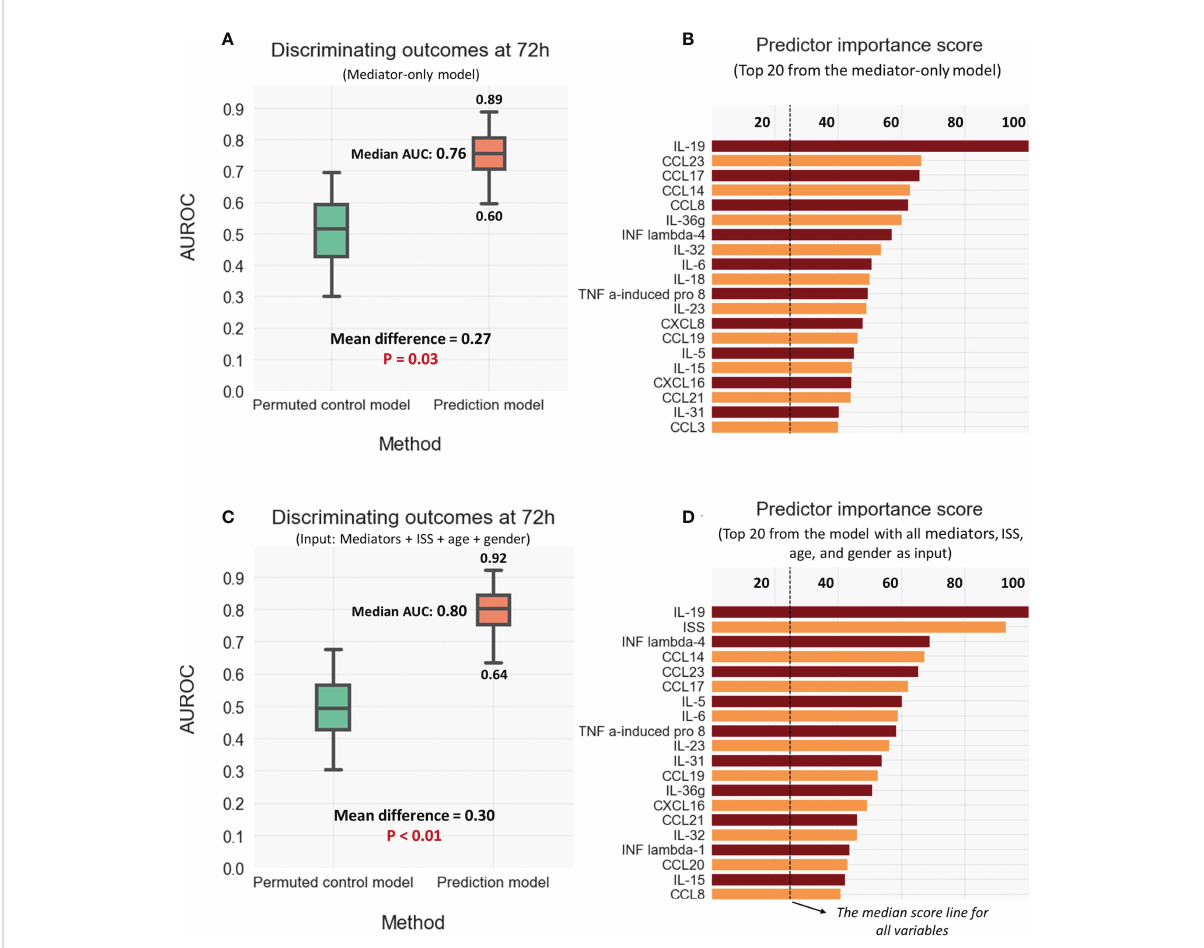
FIGURE 6 Discriminative model performance and strongest predictors of outcome (Resolver vs. Non-resolver) at 72hr: (A, B) Using mediator values only; (C, D) Using the values for ISS, Age, and sex as well as the mediators. Discriminative performance compared to the control model was measured by calculating the area under ROC curve (AUROC); the strongest predictors were selected as rated by generic predictor importance score (see